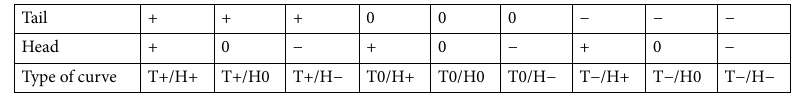
Table 2. Proposed nomenclature for the different types of EBIS spectra.